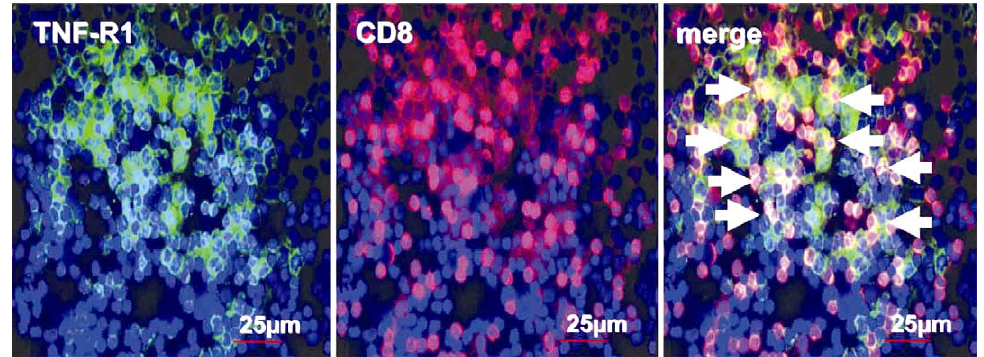
Fig. 5. Co-expression of CD8 with TNFR-1 by an immunofluorescent double staining: Immunofluorescent double staining images demonstrate a representative example of CD8 co-expression with TNFR-1 in patients with CRC (arrows). FITC green Fluoresceinisothiocyanat, Cy3 red, and DAPI 4 (cid:2) ,6-Diamidino-2-phenylindoldihydrochlorid blue. Calibration bar represents 25 µm. (The colors are visible in the online version of the article;